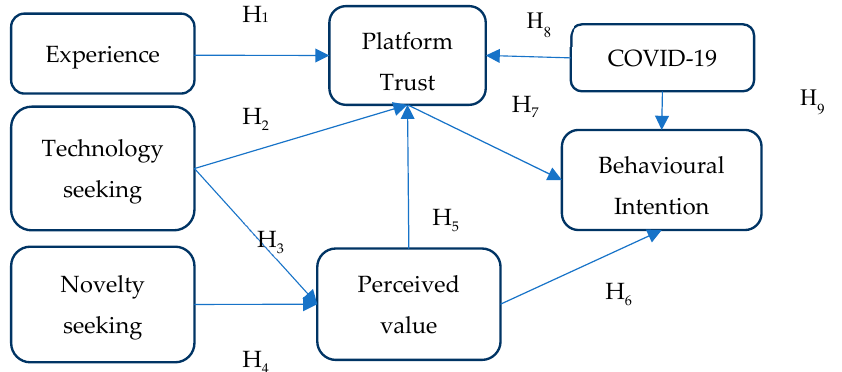
Figure 1. Behavioral intention to use/rely on sharing economy platforms during the COVID-19 pandemic. Source: authors’ own development.